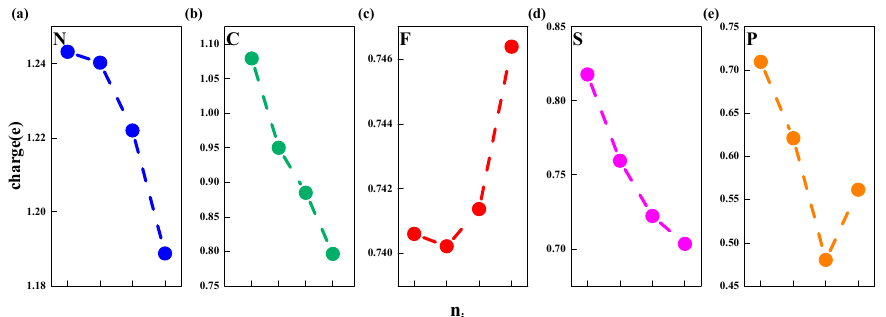
Figure 5. Effect of dopant and surface concentration on the average nonmetal charge; charge means the charge change. ( a – e ) represents N, C, F, S, P doped Ti 3 C 2 O 2 ,